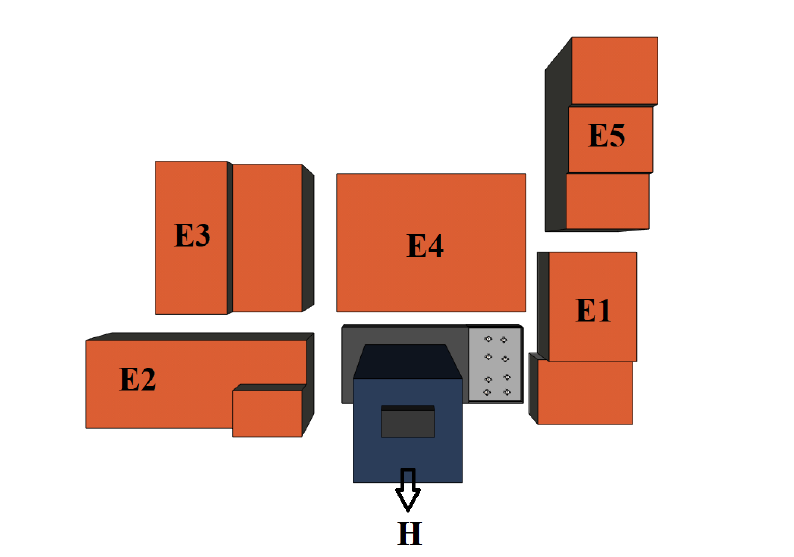
Figure 3. Top view of the tridimensional model.